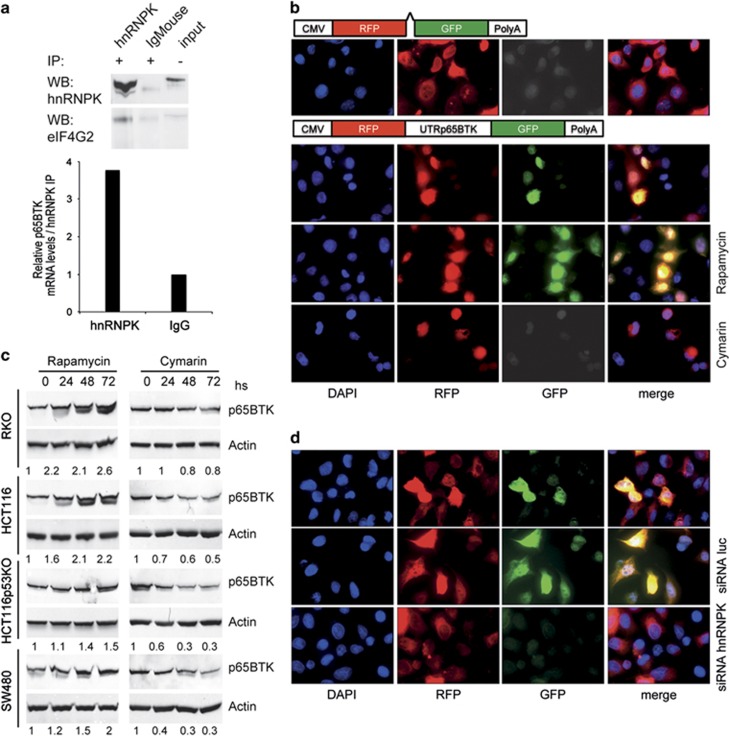
hnRNPK post-transcriptionally regulates p65BTK expression via IRES-dependent translation of exon 1b-containing mRNA. (a) Anti-hnRNPK antibodies immunoprecipitate a complex containing hnRNPK, eIF4G2 (top) and p65BTK mRNA (bottom) from HCT116p53KO lysates. (b) Fluorescence of HeLa cells transfected with a bicistronic vector encoding RFP under the control of CMV promoter and GFP not preceded by a regulatory region (first row) or under the control of p65BTK 5′UTR (second to fourth row) and left untreated (second row) or treated with Rapamycin 200 nM (third row) or Cymarin 100 nM (fourth row) for 36 h. DAPI was used to stain nuclei. (c) Time-dependent variation of p65BTK expression after treatment of colon cancer cells with 200 nM Rapamycin (left) and 200 nM Cymarin (right). Fold variation of p65BTK protein expression of each sample was calculated and normalized to actin by ImageJ program. (d) HeLa cells were transfected with the same bicistronic reporter as in (b) and luc-targeted siRNAs (second row) or hnRNPK-targeted siRNAs (third row). DAPI was used to stain nuclei.